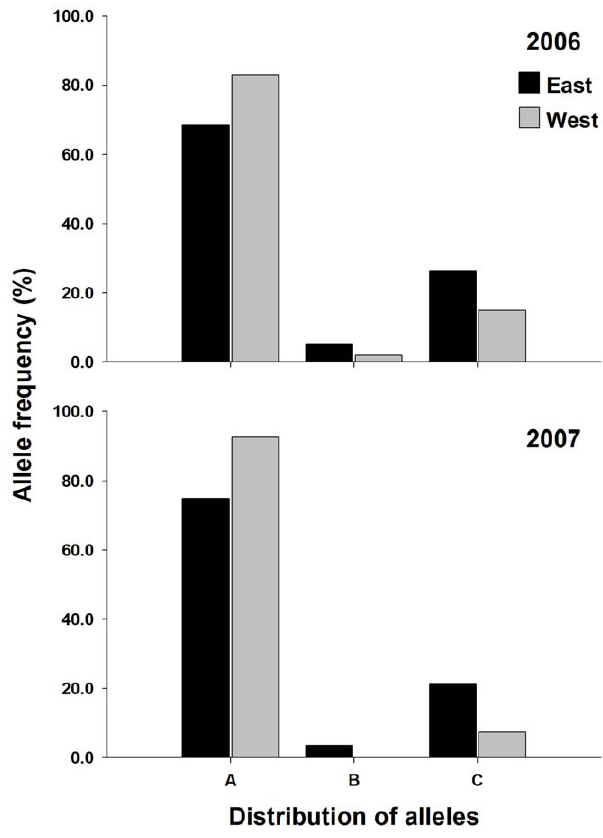
Figure 6. Distribution of alleles for microsatellite locus AC2 in 2006 and 2007.